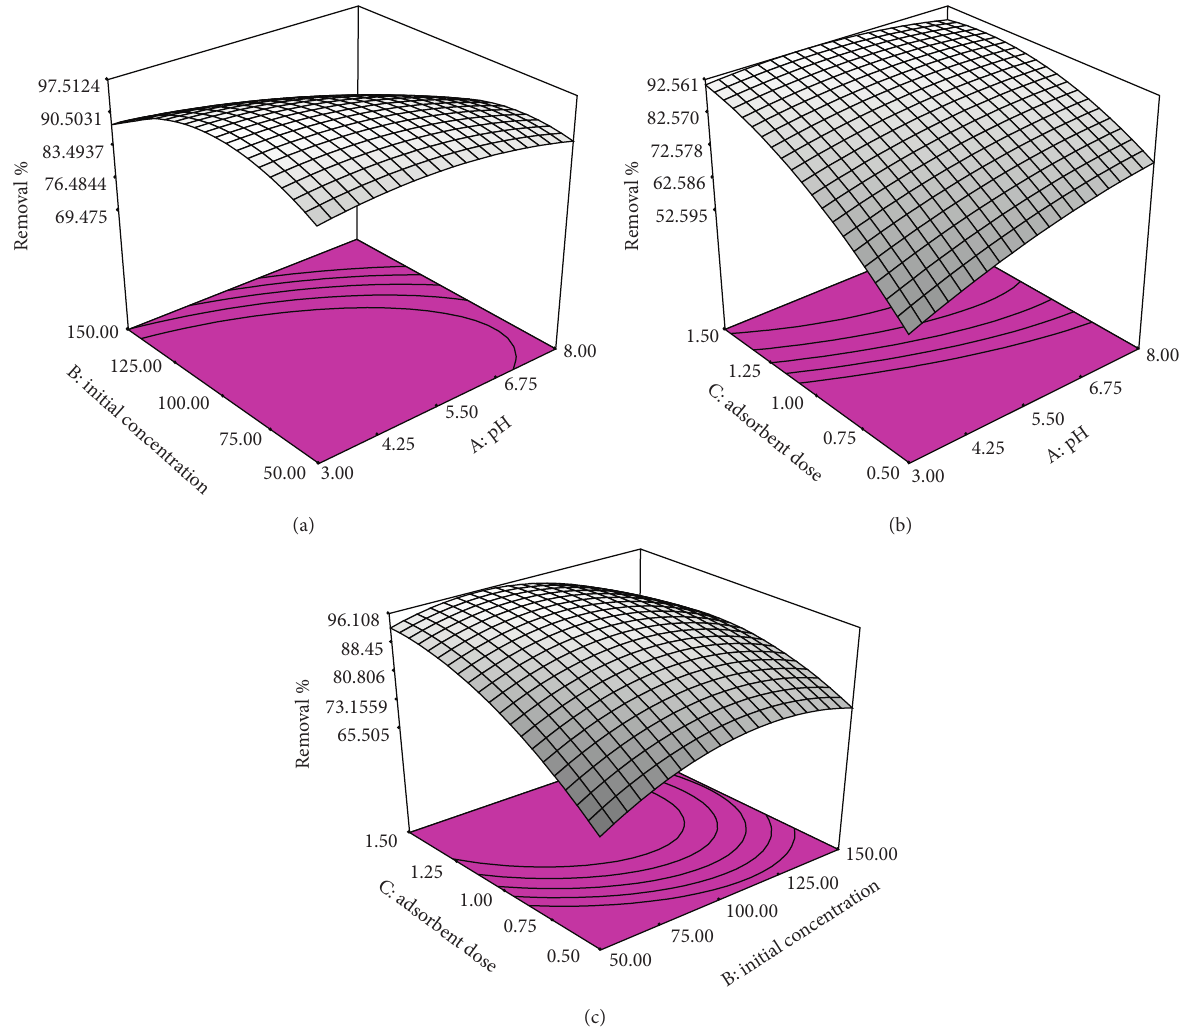
Figure 4: Surface plots for the effects of (a) the solution of pH and initial Pb (II) ion concentration; (b) initial Pb (II) ion concentration and (c) adsorbent dose; and (c) adsorbent dose and initial Pb (II) concentration on the removal